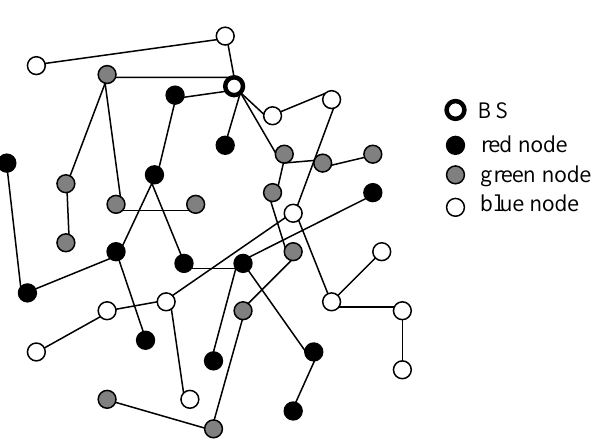
Figure 1. Disjoint tree